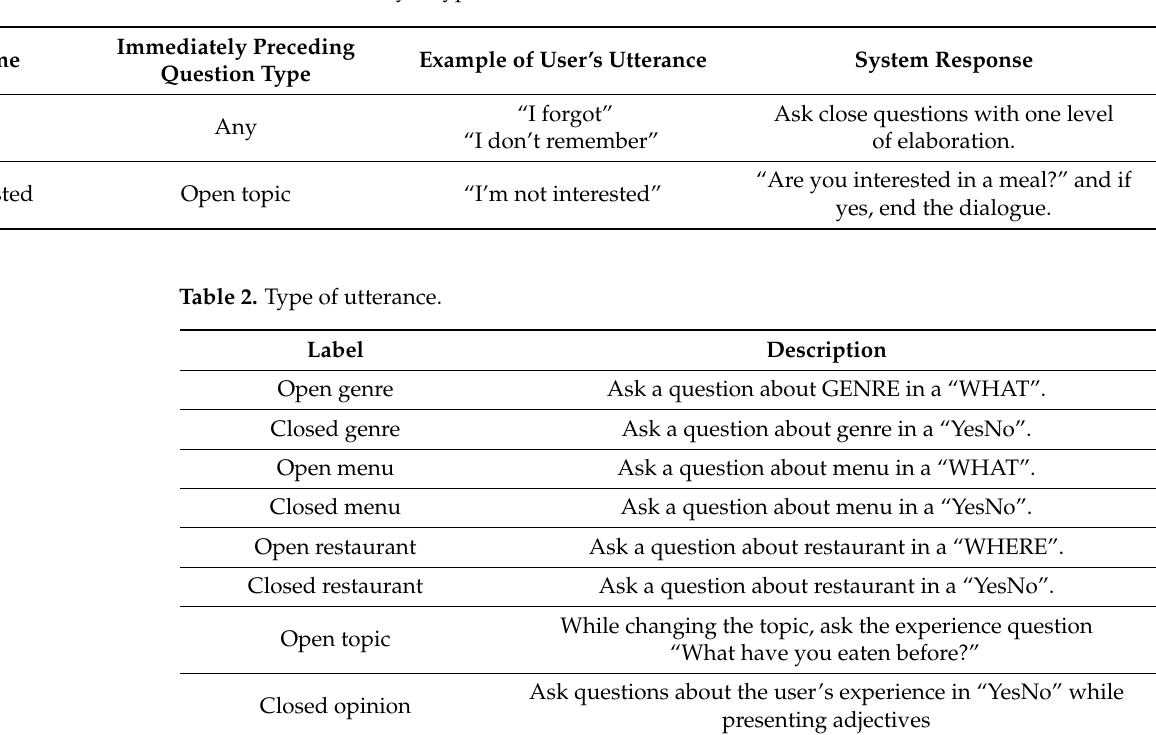
Table 1. Error recovery—Type.